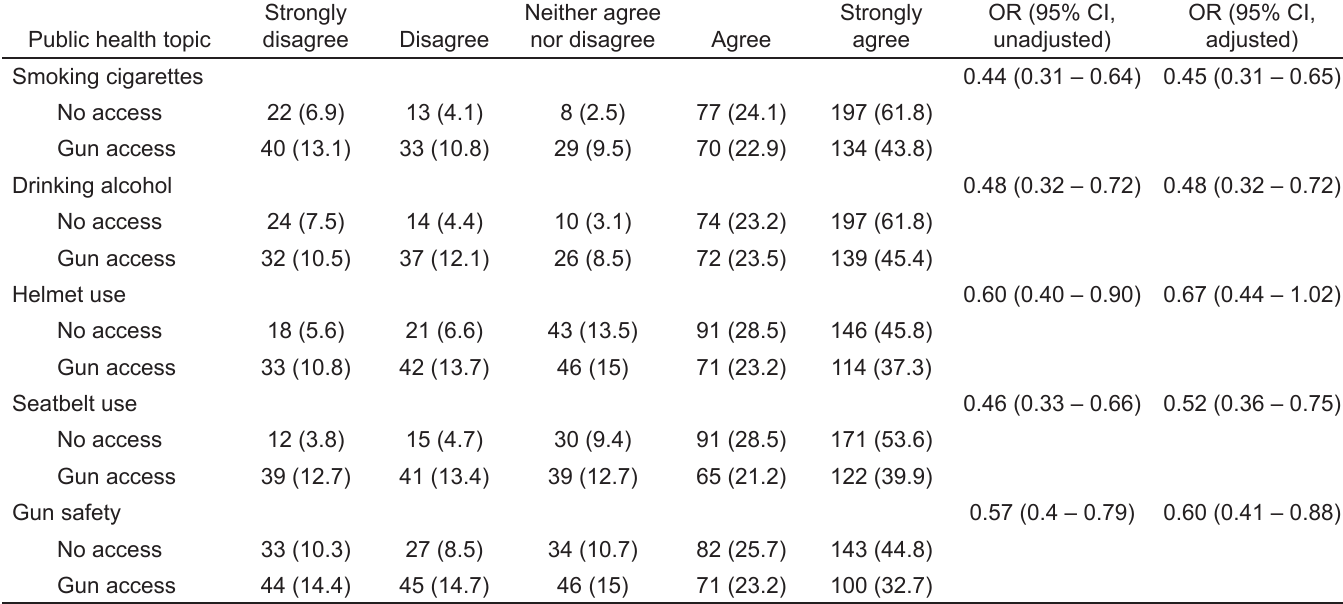
Table 2. Opinion of study patients on discussing different public health topics with a provider: gun access vs no gun access.